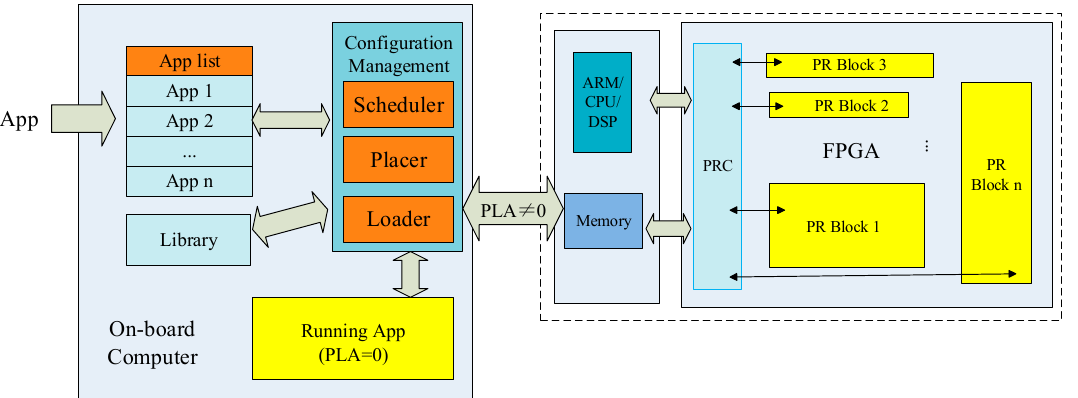
Figure 4. The on-board apps configuration module.